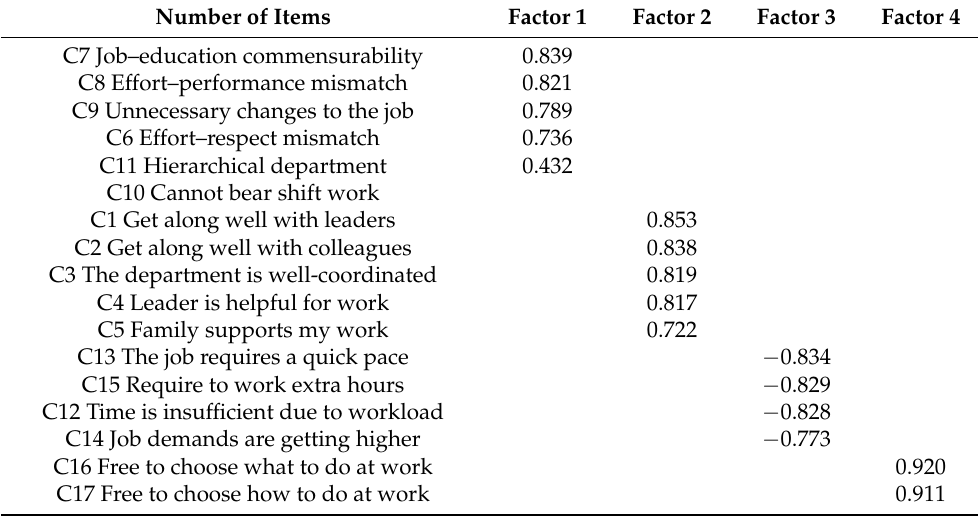
Table 1. The Core Occupational Stress Scale with factor load values.